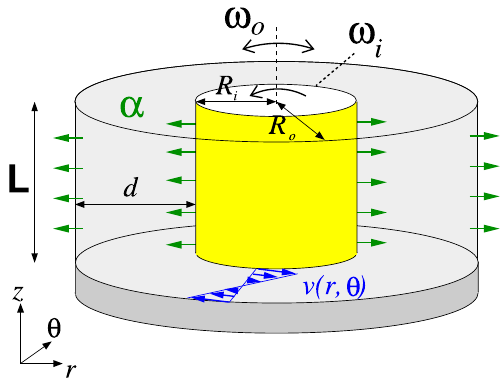
Figure 1. Schematics of the Taylor–Couette system, illustrating radial flow in a counter-rotating configuration, including a sketch of the laminar velocity profile, v ( r , θ) (not to scale). The radial flow can be outward, (α > 0 ) (as shown), or inward, (α < 0 ) . Only the bottom lid serving as one of the axial end walls is indicated (dark